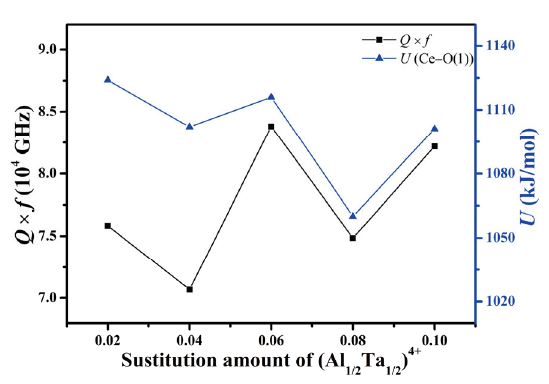
Fig. 12 Q × f and the Ce–O(1) lattice energy of CZMAT ceramics as a function of the value of x.